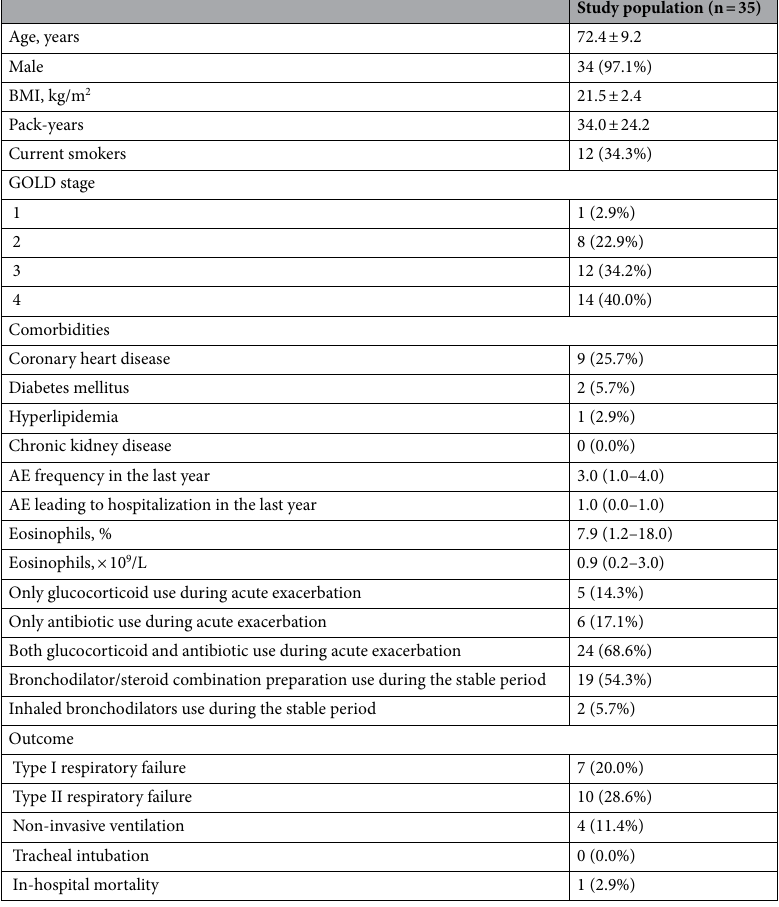
Table 1. The clinical characteristics of study subjects. BMI body mass index, GOLD global initiative for chronic obstructive lung disease, AE acute